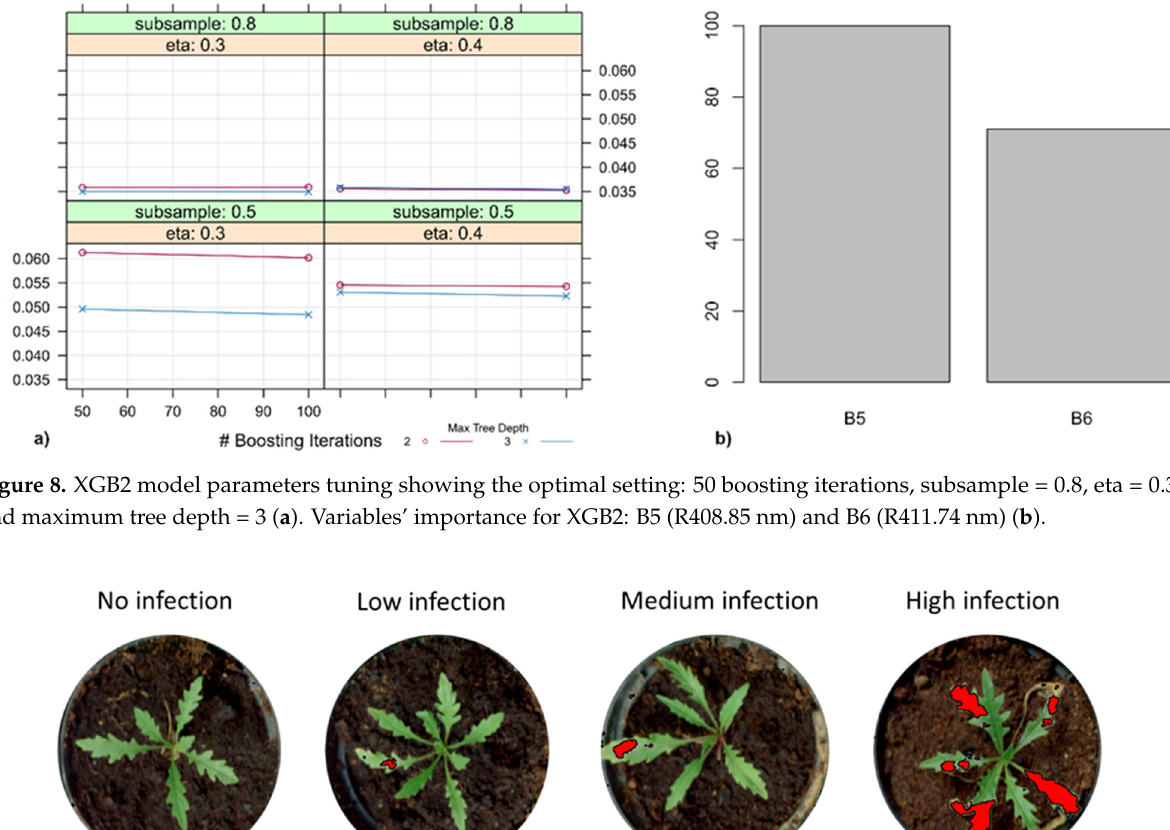
10 of 15 Figure 7. XGB1 model parameters’ tuning procedure yielded the following optimal setting: 50 boosting iterations, sub- sample = 0.8, eta = 0.3, and maximum tree depth = 3 ( a ). The most important variables in explaining the differences between the infected and healthy samples, in order of decreasing importance, are B5 (R408.85 nm), B3 (R403.09 nm), B6 (R411.74 nm), and B18 (R446.45 nm) ( b ). Hence, a second model (XGB2) was trained by using the same training and testing datasets, but only with the above-mentioned predictors variables that were shown to be important in the previous XGB1 model. The XGB2 parameters that were chosen for the